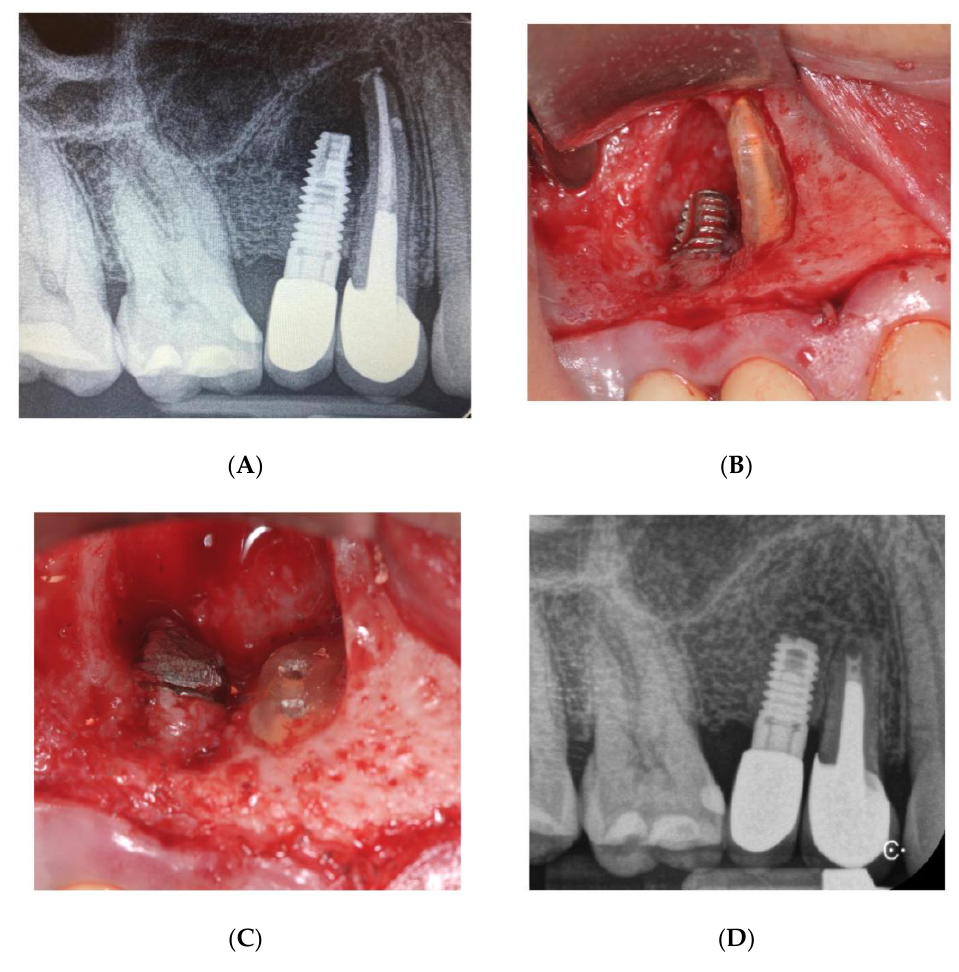
Figure 6. Case 2 ( A ) Preoperative image showing the presence of a radiolucency between the implant apex and the adjacent tooth. ( B ) Clinical view of the apex prior to the resection. ( C ) Implant apical resection and tooth apex resection with both root canals ready to receive the filling material. ( D ) 2 years follow-up.